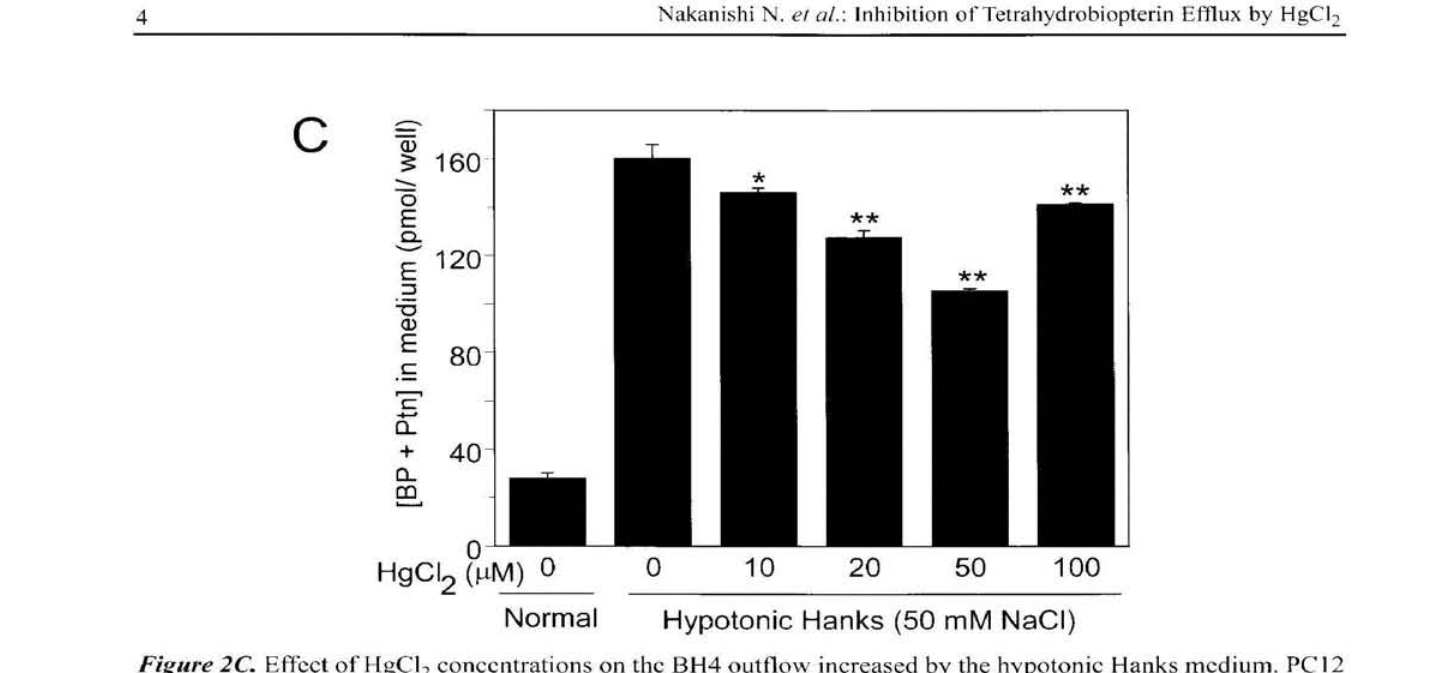
Figure 2C. Effect of HgCl 2 concentrations on the BH4 outflow increased by the hypotonic Hanks medium. PC 12 cells were incubated in the normal Hanks medium (138 raM NaCI) and hypotonic Hanks medium (50 mM NaCI) in the presence of various concentrations of HgCl 2 for 10 min in a C0 2 incubator at 37°C. Values are the means ± SD (n=4). *p<0.01 and **p<0.001 vs. the value obtained with hypotonic Hanks without HgCl 2